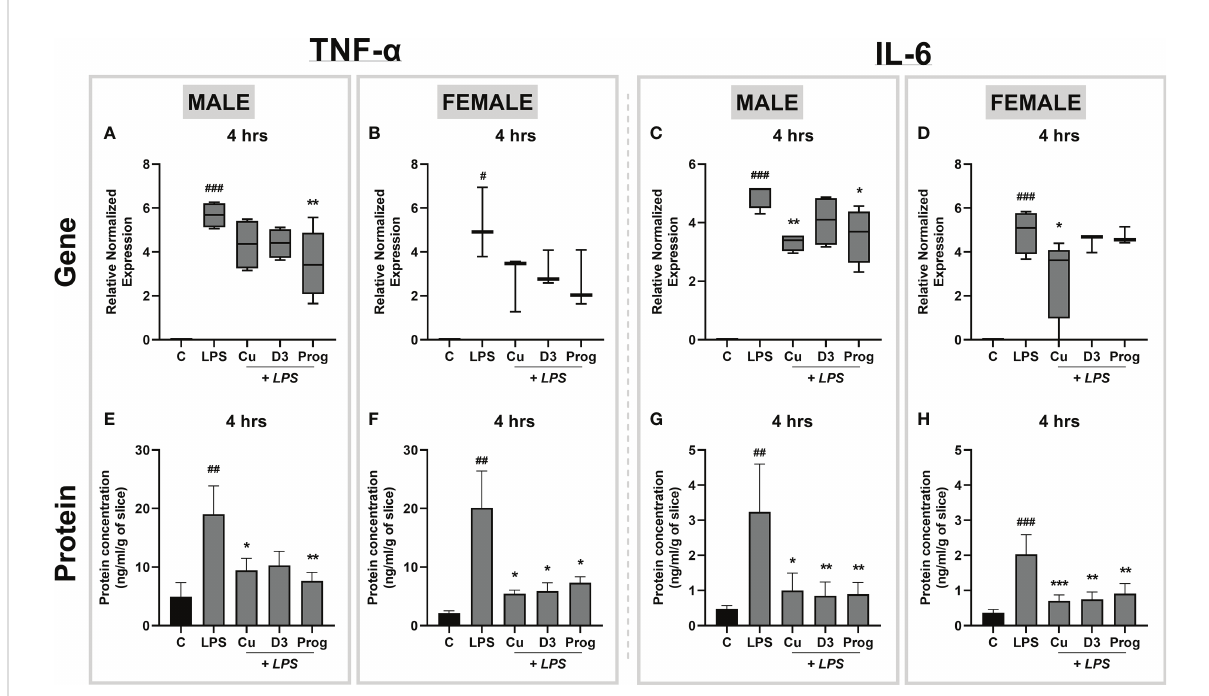
FIGURE 7 Effect of curcumin, 1 a ,25-dihydroxyvitamin D3, and progesterone on LPS-induced in fl ammation in the rat placental slices. Following a 4-hour preincubation phase with inhibitors, male and female placental slices were treated with LPS (5 µg/ml) in the presence and absence of curcumin, 1 a ,25-dihydroxyvitamin D3, or progesterone for an additional 4 hours. Gene expression of proin fl ammatory cytokines was subsequently determined by qPCR analysis (A-D) , while cytokine release in the culture media was analyzed by ELISA (E-H) . Data are shown as Tukey boxplots or mean ± SEM; n ≥ 4. *P < 0.05; **P < 0.01; ***P < 0.001; # P < 0.05; ## P < 0. 01; ### P < 0. 001. # compared to the control; *compared to